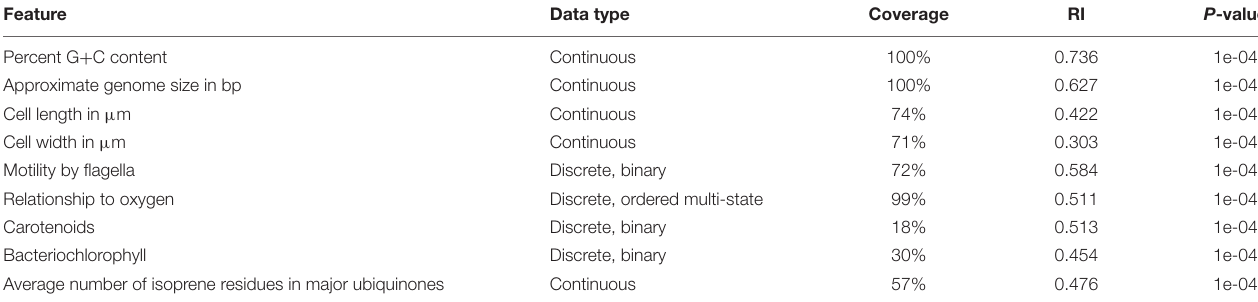
TABLE 2 | P -values from the tip-permutation test of the GBDP tree shown in Figures 1 – 9 and other results obtained for the selected genomic and phenotypic